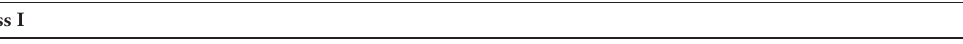
Indications for mitral valve surgery.